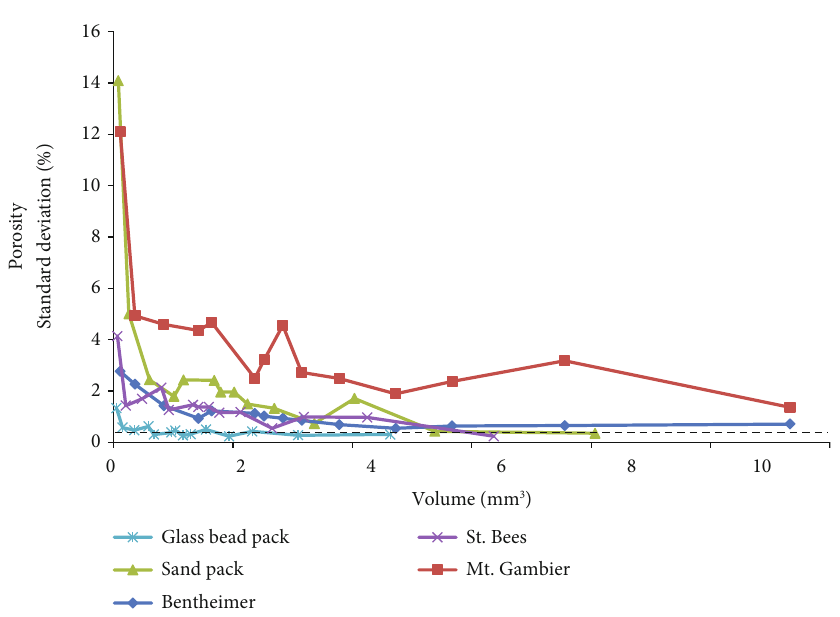
Figure 6: Porosity standard deviations of the fi ve samples versus subvolume size. The dashed horizontal black line is the 0.5% threshold. The power-law fi t for Mt. Gambier is indicated as a thin black line. Table 4: Fitting equations for the REV analysis using the standard deviation approach.